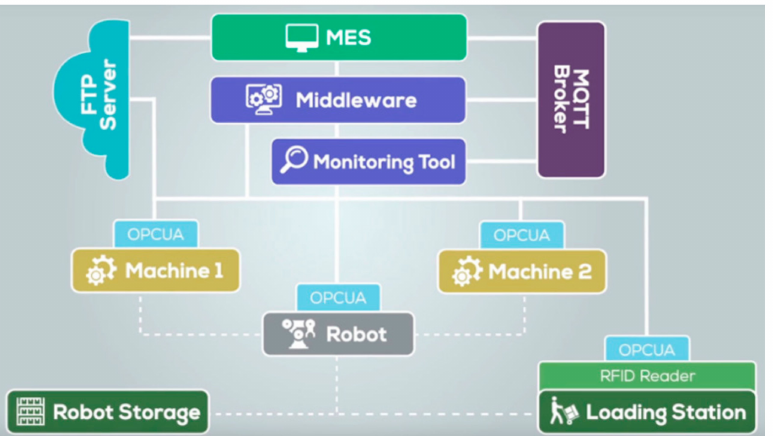
Figure 7. Simplified diagram of the HyProCell modular architecture (http://www.hyprocell-project. eu/project/innovation-highlights/ (accessed on 16 January 2021)) developed by SmartFactory- KL [12]. Copyright 2019 Parsha Pahlevannejad